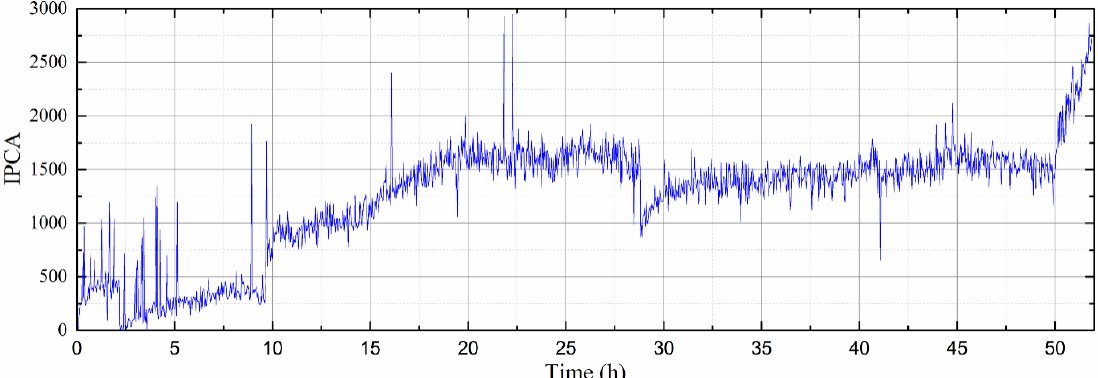
Figure 13. Variations of IPCA from the Otsu method.